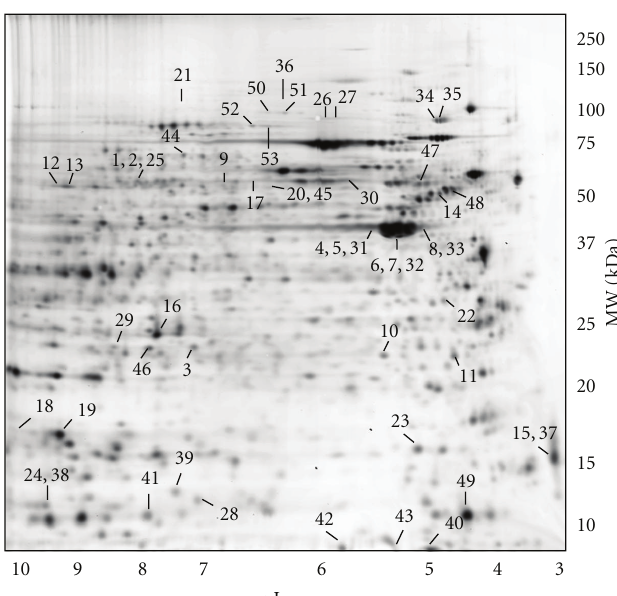
Figure 4: 2D-DIGE gel representing di ff erentially expressed proteins identified in the colon tissue of Il10 − / − mice compared to C57 mice at 7 and 12 weeks of age, respectively. Protein annotations are shown in Table 4. The approximate isoelectric point (pI) and molecular weight (MW) in kDa are given on the x - and y -axes, respectively.